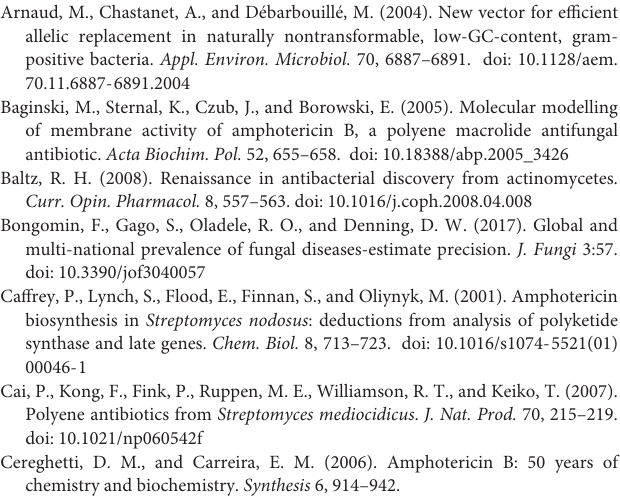
FIGURE S3 | Control study testing the response of (cid:49) lnrLMN P lnrL 231 biosensor to a collection of 13 non-polyene antibiotics (strain TMB5600). FIGURE S4 | Molecular structures of the non-polyene antibiotics used in the control study presented in Supplementary Figure S3 . TABLE S1 | Oligonucleotides used in this